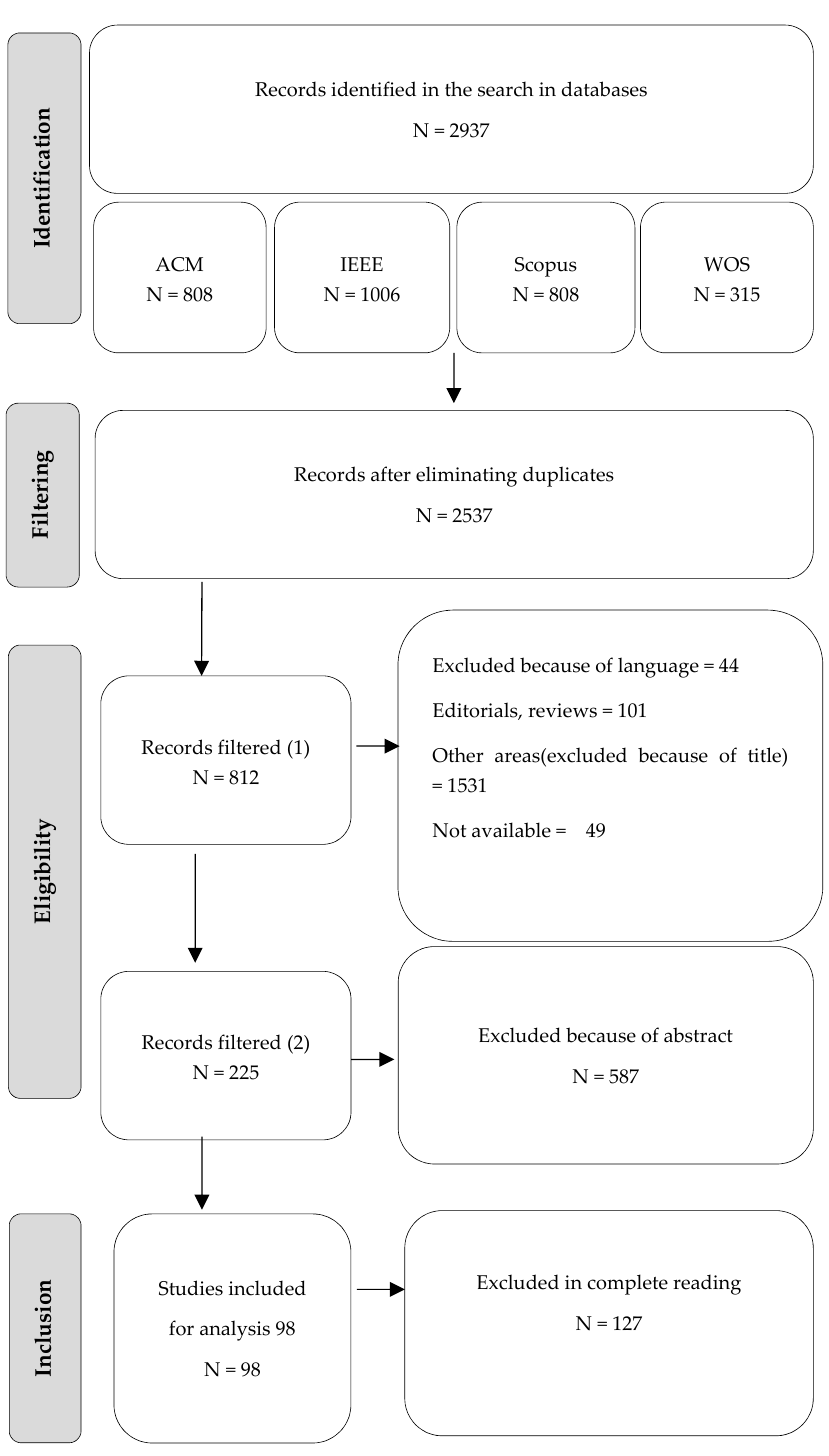
Figure 2. Flow chart showing study selection.